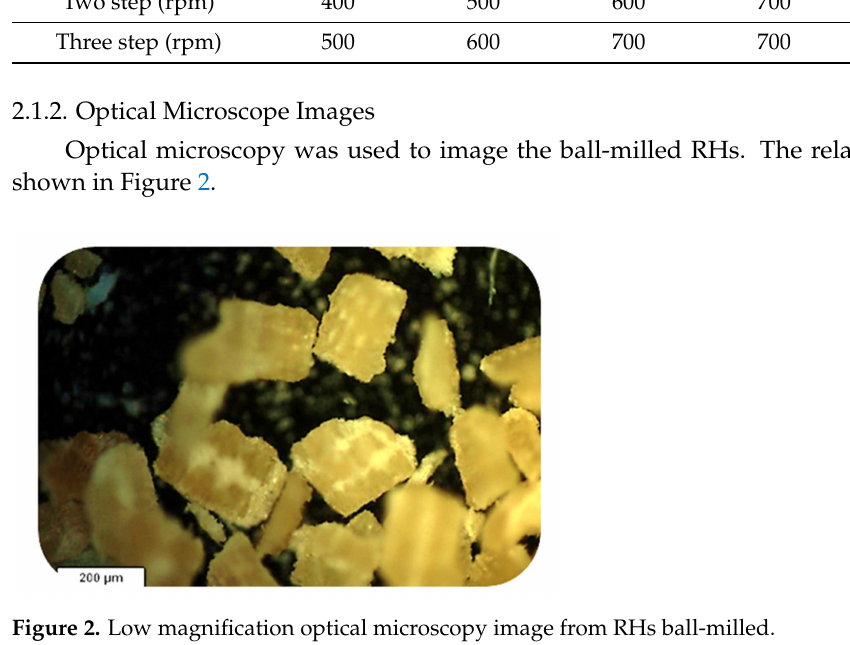
Figure 2. Low magnification optical microscopy image from RHs ball-milled.